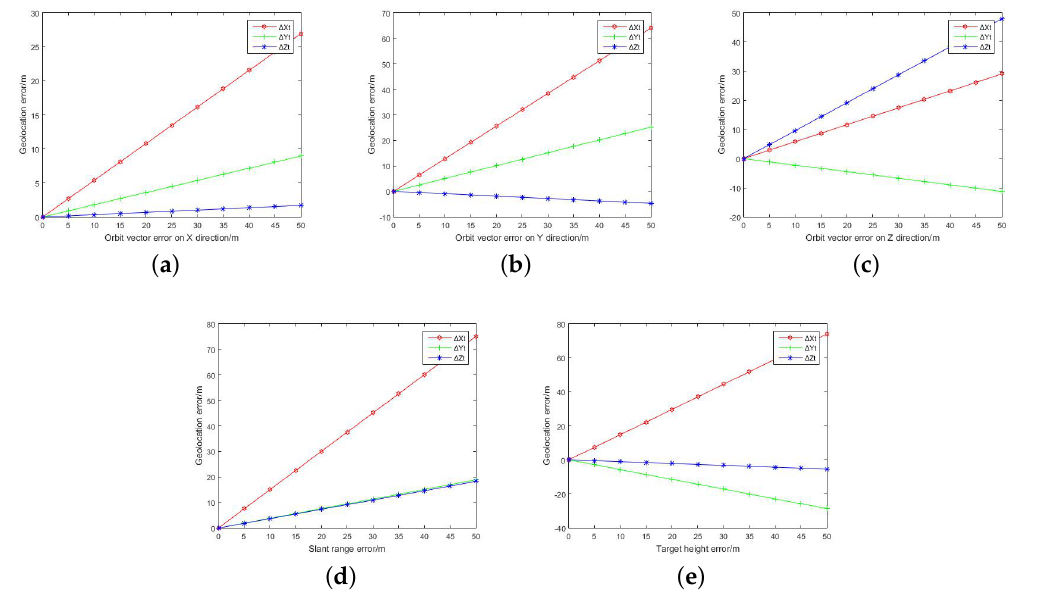
Figure 3. The relationship between error in different SAR parameters and geolocation error on 20080131 and 20080317: ( a ) shows geolocation error when error added in X direction of orbit vector. ( b – e ) are geometric deviation changing with Y s , Z s , R and h